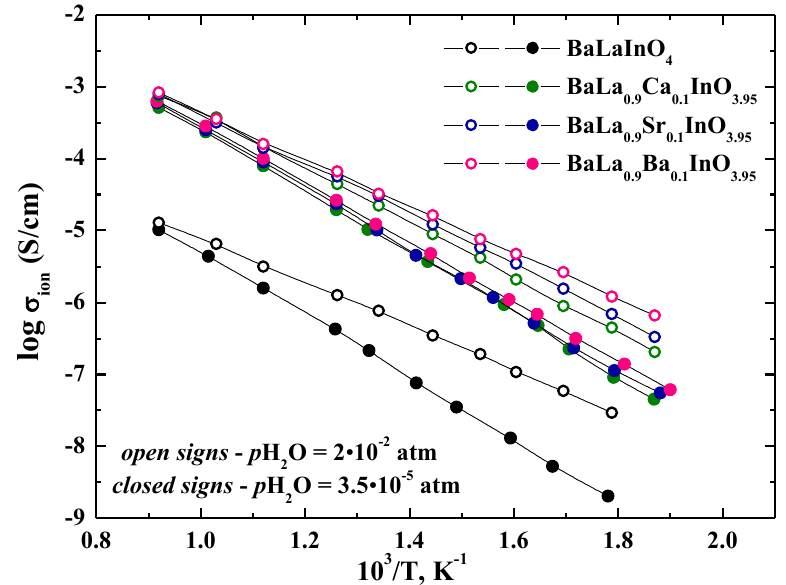
Figure 7. The temperature dependencies of the ionic conductivities of BaLaInO 4 and BaLa 0.9 M 0.1 InO 3.95 (M = Ca 2+ , Sr 2+ , Ba 2+ ) at dry Ar (filled signs) and wet Ar (closed signs).